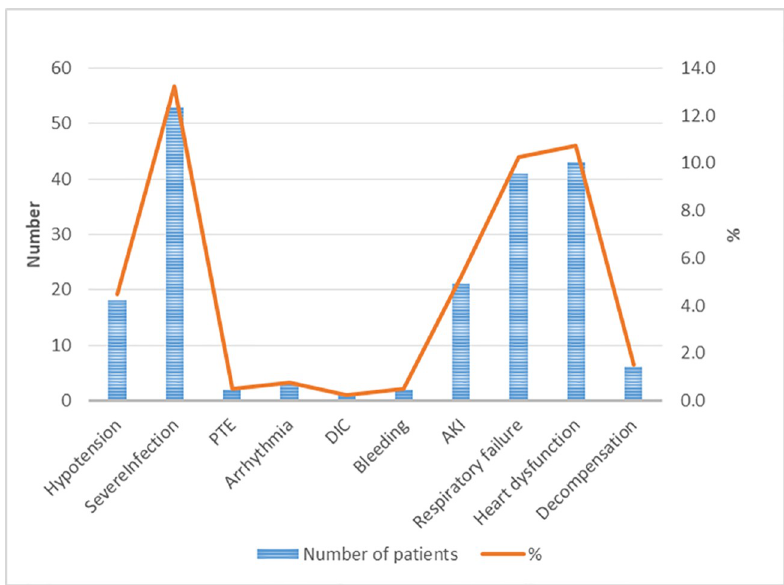
Fig 2. A chart showing the frequencies of acute complications that destabilized febrile neutropenia patients at the emergency department. % indicates the proportion of the entire patients (N = 400). “Decompensation” indicates decompensation of preexisting comorbidities. PTE, pulmonary thromboembolism; DIC, disseminated intravascular coagulopathy; AKI, acute kidney injury.